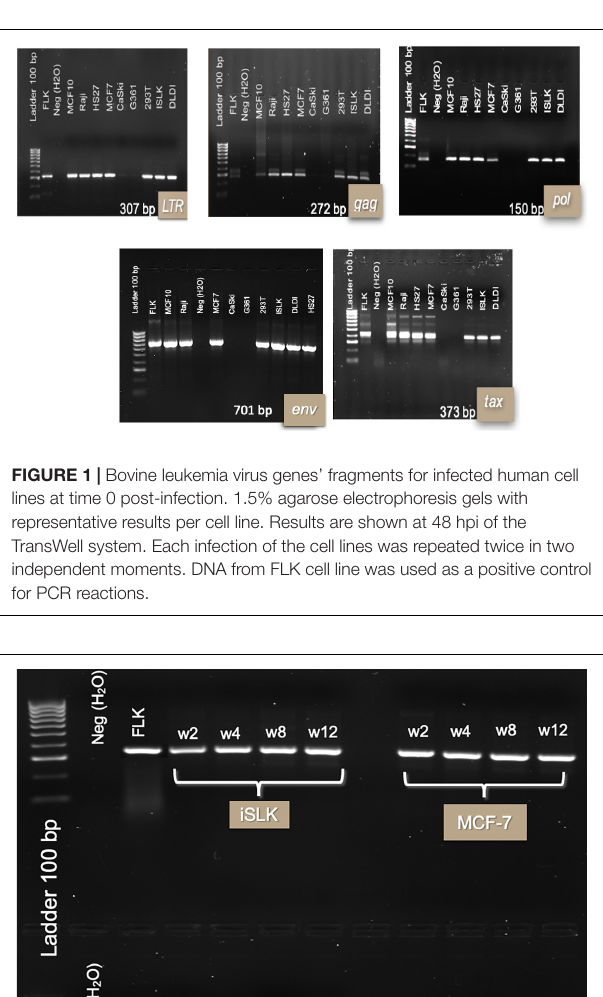
for most BLV genes following incubation in TransWells.